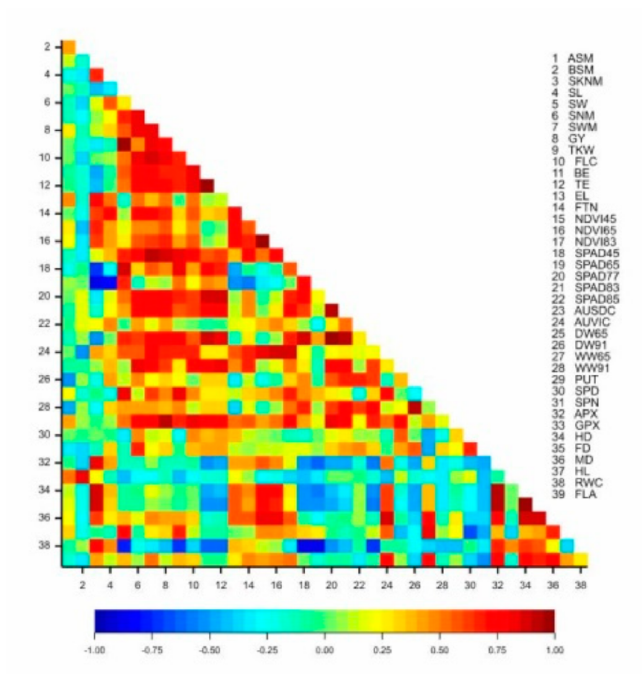
Figure 3. Pearson’s correlation coefficients for the plant development, morphological, physiological and biochemical traits and the yield components of eight near-isogenic lines of spring durum wheat in the rain-fed treatment (2013–2014). Critical r values for the correlation coefficients: 0.6319 ( p < 0.05); 0.7646 ( p < 0.01); 0.8721 ( p < 0.001).